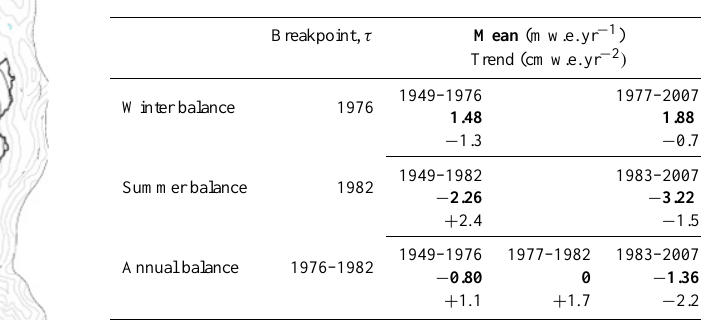
Table 1. Time structure identified by the analysis of variance in the seasonal components of the balance: breakpoint τ , mean (bold face values) and trend in subsequent periods (Eckert et al.,